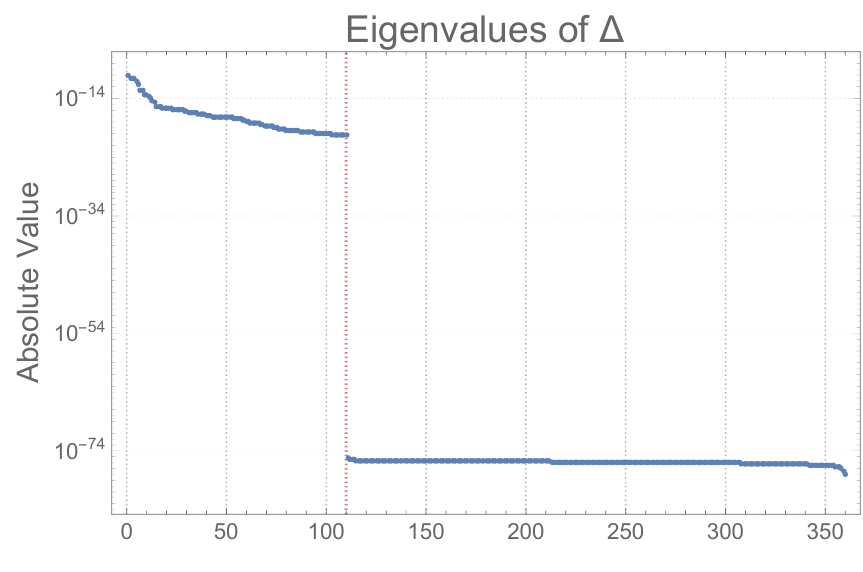
. A red vertical 7